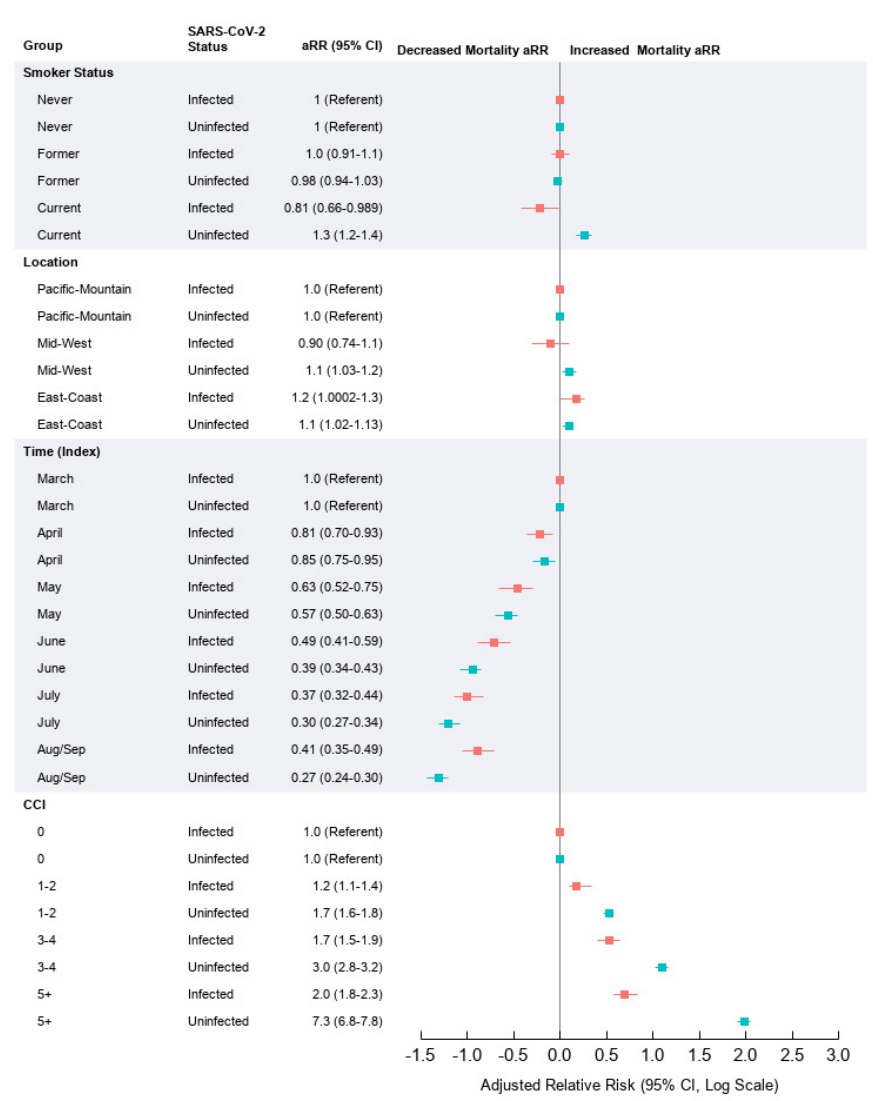
Figure 1. Forest plot of selected characteristics and adjusted relative risk of 30-day mortality by SARS-CoV-2 infection status among male veterans (n = 341,166). Adjusted relative risk of 30-day mortality in infected (red) and uninfected (blue) cohorts by study variable. Models were adjusted for age, location, time, and Charlson Comorbidity Index (unless the indicated characteristic). aRR = adjusted relative risk (Le Cam–Stein shrinkage). BMI = body mass index (kg/m 2 ). CCI = Charlson Comorbidity Index.